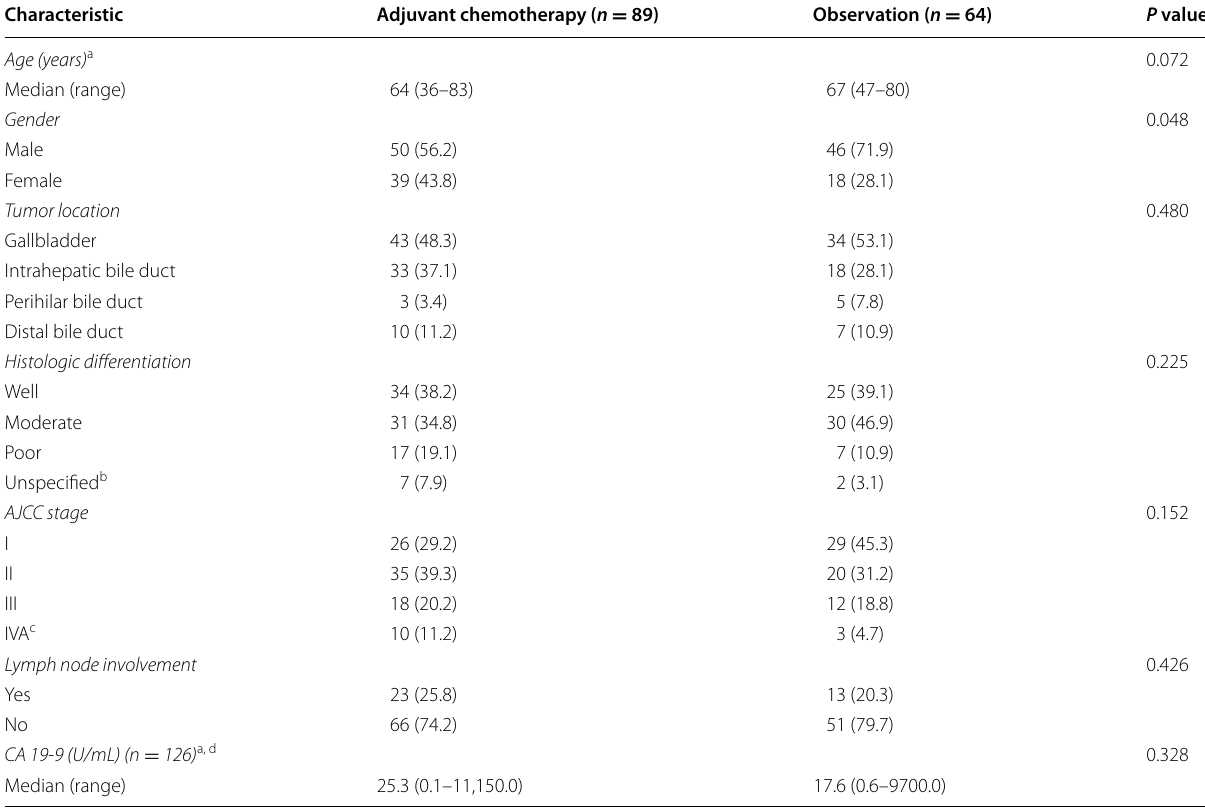
Table 1 Comparison of characteristics between two groups of biliary tract cancer (BTC) patients undergoing microscopi- cally margin-negative (R0) resection